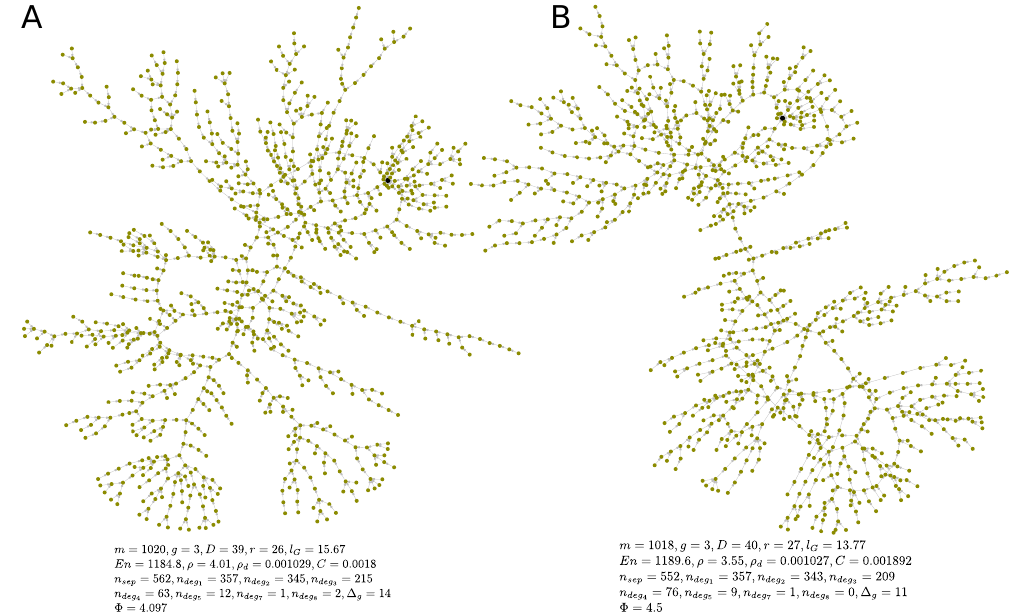
Figure 7. Two examples ( A , B ) of algorithmically generated realizations of rule-based directed random graphs of the HLS. The output nodes are marked with black color. Algorithm parameters: N v = 996, N inp = 357, N l = 41, P e = 0.035, P o = 0.21. The metrics of topological fitness to anatomy-based graphs presented in figure are defined in Section 4.